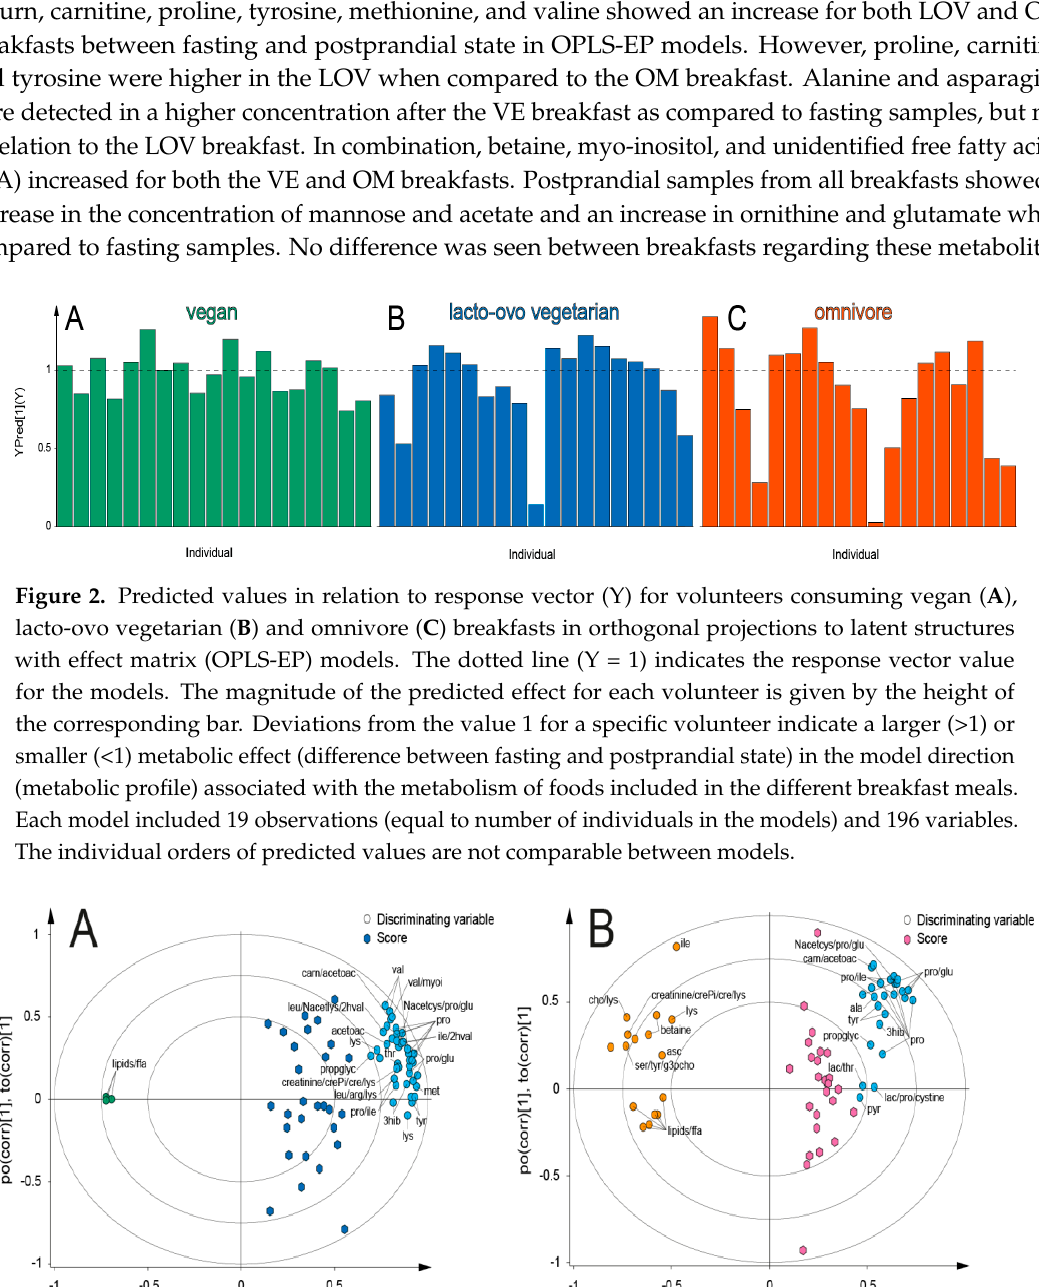
Figure 3. Biplots in orthogonal projections to latent Structures with effect projection (OPLS-EP). Model ( A ) ( n = 28) compared the difference between lacto-ovo vegetarian (LOV) and vegan (VE) breakfasts. Model ( B ) ( n = 26) compared the difference between LOV and omnivore (OM) breakfasts. Both models included 196 variables. Scores (hexagon symbols) denote the calculated effect matrix in each individual. Dark blue = difference in metabolic response between LOV and VE. Pink = difference in metabolic response between LOV and OM. Labeled circles denote selected discriminating variables (metabolites) in the two models. Green = metabolites increasing in VE breakfast in relation to LOV breakfast. Blue = metabolites increasing in LOV breakfast in relation to VE and OM breakfasts. Red = metabolites increasing in OM breakfast in relation to LOV breakfast.